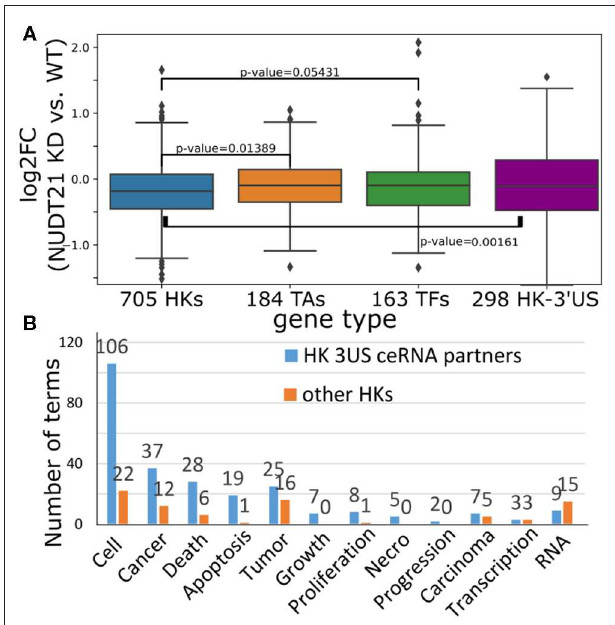
FIGURE 6 | (A) Log 2 fold change (NUDT21 KD vs. WT) of 705 HK, 184 TA, and 163 TF genes that are (potential) ceRNA partners of 3 ′ US genes. Log 2 fold change of 298 HK genes that are 3 ′ US genes is displayed on the rightmost box. (B) Number of terms with the keyword indicated on the x-axis. Numbers on the bar represent the actual number of